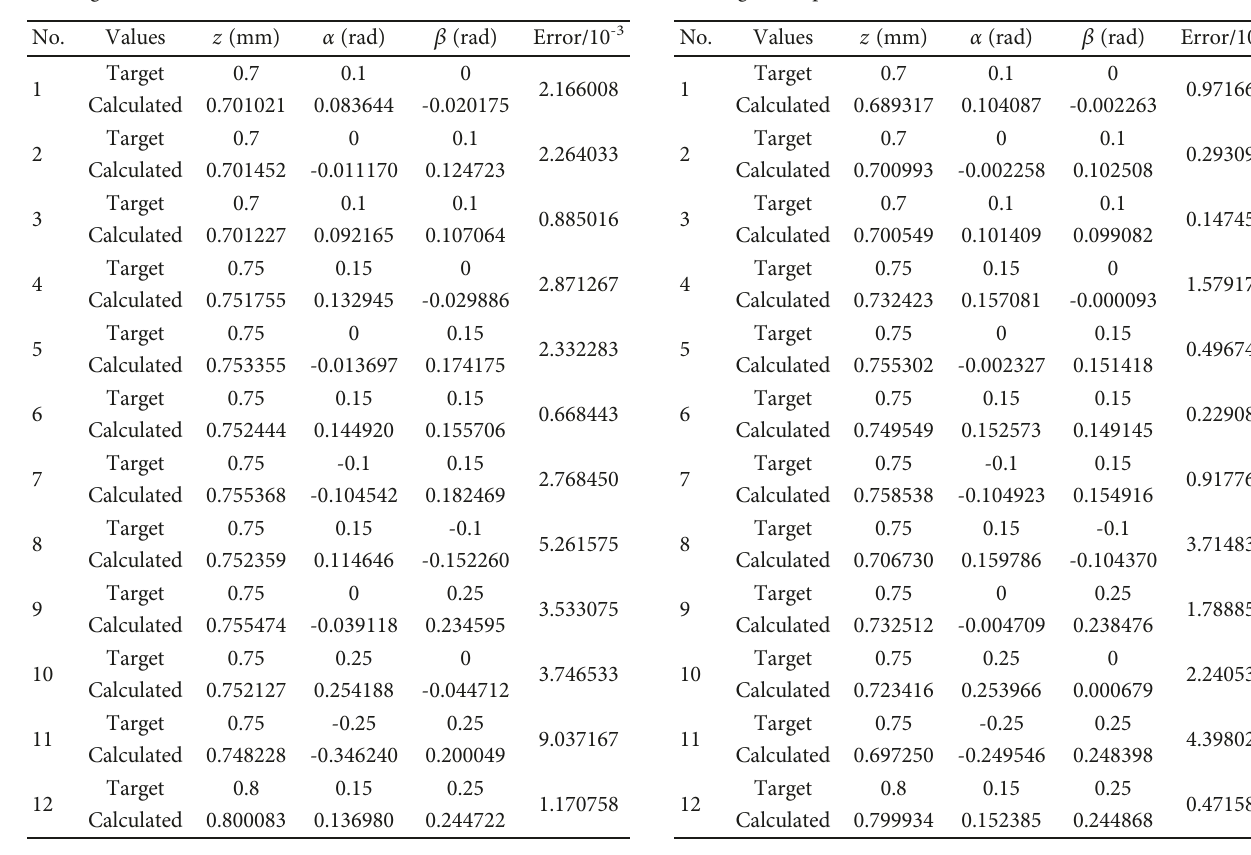
Table 1: Forward kinematics results of the parallel manipulator by utilizing the BP neutral network.